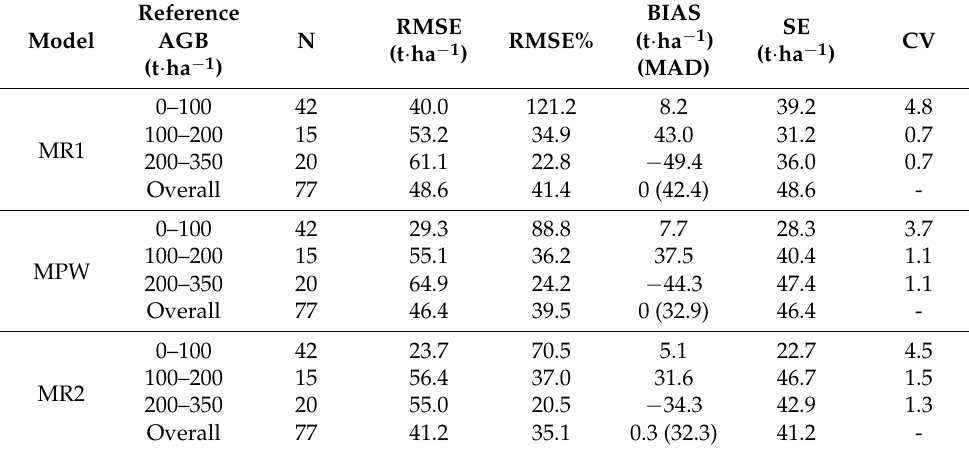
Table 7. Accuracy of the models in terms of the averaged metrics from 500 bootstrap repetition stratified by the reference AGB range: sample size (N), root mean square error (RMSE), relative RMSE (RMSE%), bias, mean absolute deviation (MAD), standard deviation of the error ( σ = SE) and coefficient of variation (CV) of the error (when CV >1, random error dominates; when CV<1, bias